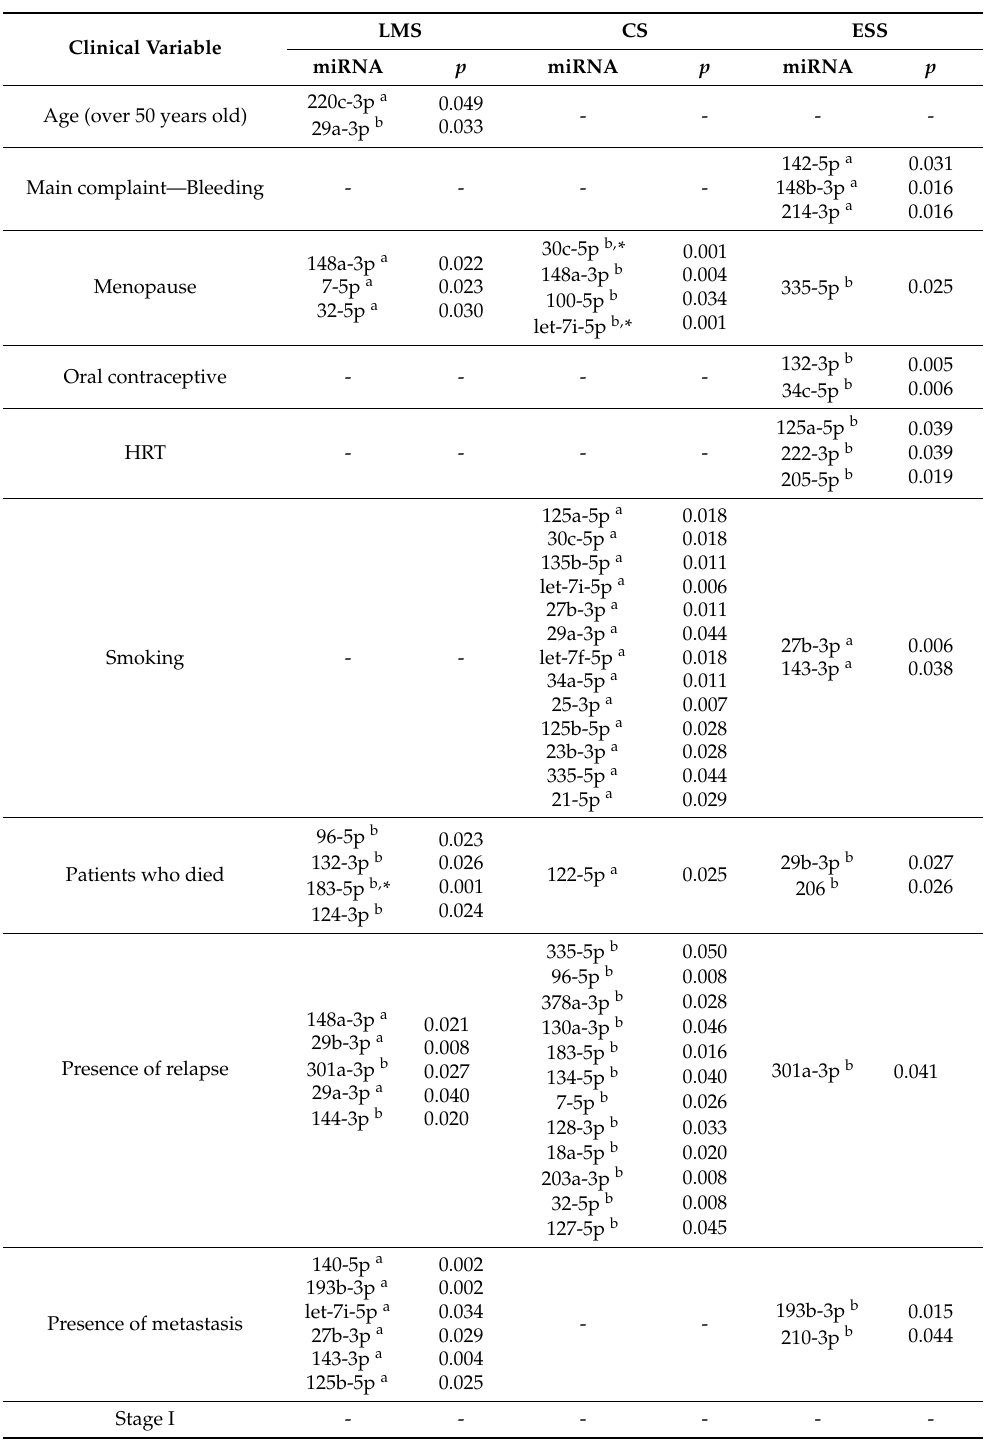
Table 3. Association between the expression of the microRNAs (miRNAs) and the clinical pathological features ( n = 80) c